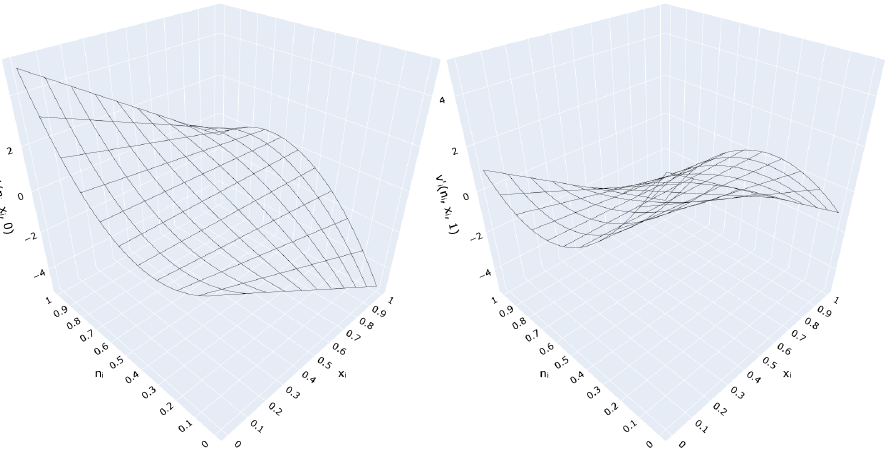
Figure 4. Gradient of the considered VCM transformation ( left ) for z = 0 and ( right ) for z =